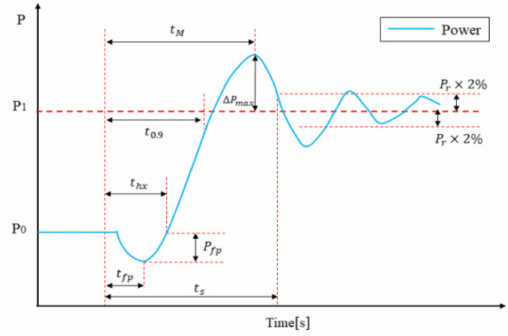
Figure 7. Dynamic response of power